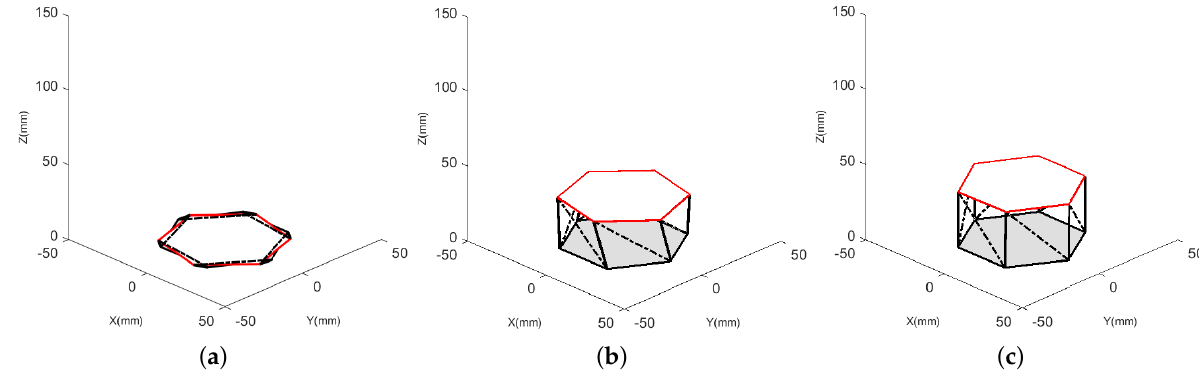
Figure 17. Origami Kresling single link kinematics vadidation, with parameters α = 38 ◦ , β = 30 ◦ and a = 30 mm. ( a ) Collapsed state. ( b ) Deploying state. ( c ) Deployed state.